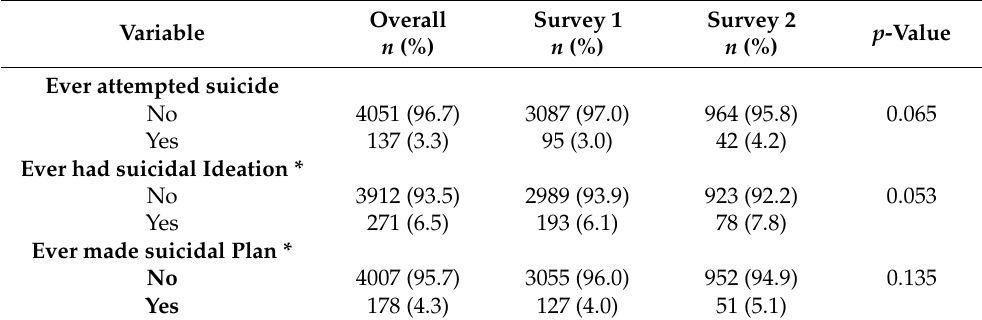
Table 2. Prevalence of suicidal attempts by survey year among secondary school-going adolescents in Kilimanjaro region, northern Tanzania.